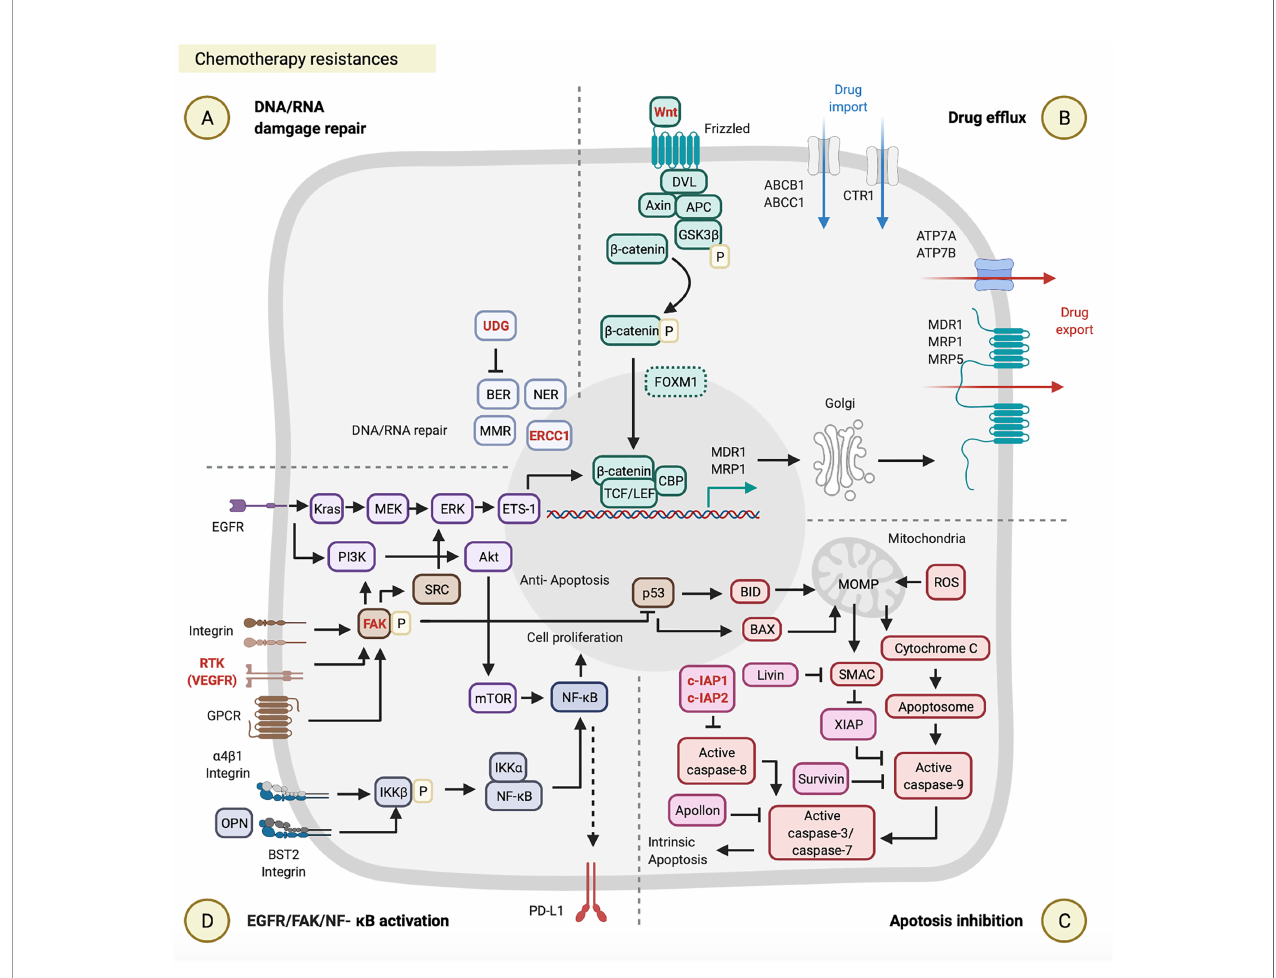
FIGURE 2 | Chemotherapy resistances. Chemotherapy resistance is involved in (A) DNA/RNA damage, (B) drug ef fl ux, (C) apoptosis inhibition, and (D) epidermal growth factor receptor (EGFR)/focal adhesion kinase (FAK)/nuclear factor (NF)- k B activation. These fi gures were created with